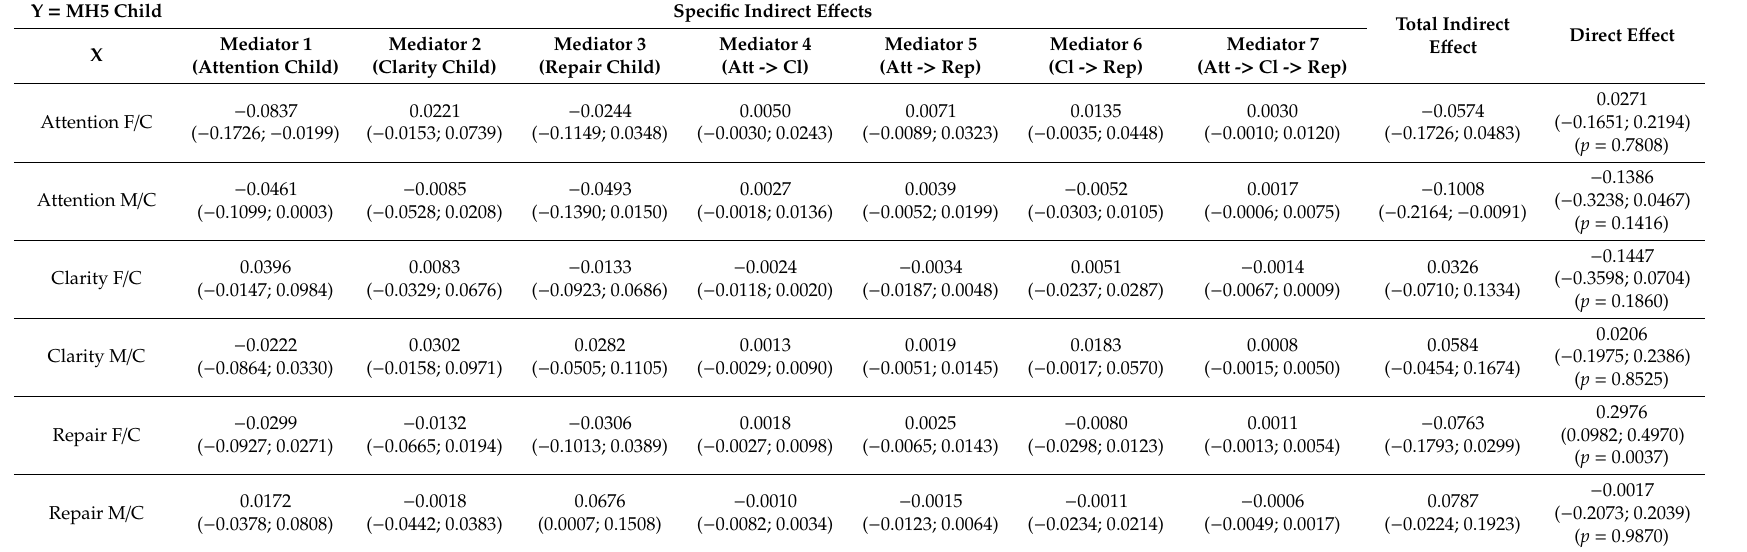
Table 3. Indirect and direct e ff ects for the mediation model using EI perceived by parents about children as explanatory